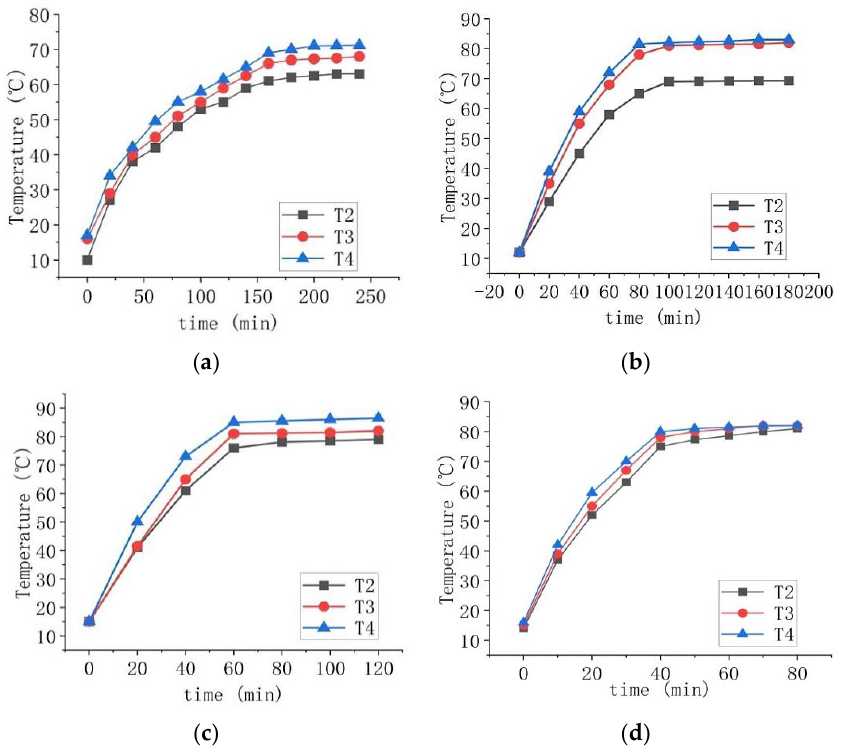
Figure 4. Temperature profile of heat flow density of 222 ~1778 W·m −2 at an inclination angle of 90°. ( a ) q = 444 W·m −2 , ( b ) q = 889 W·m −2 , ( c ) q = 1333 W·m −2 , ( d ) q = 1778 W·m −2 .